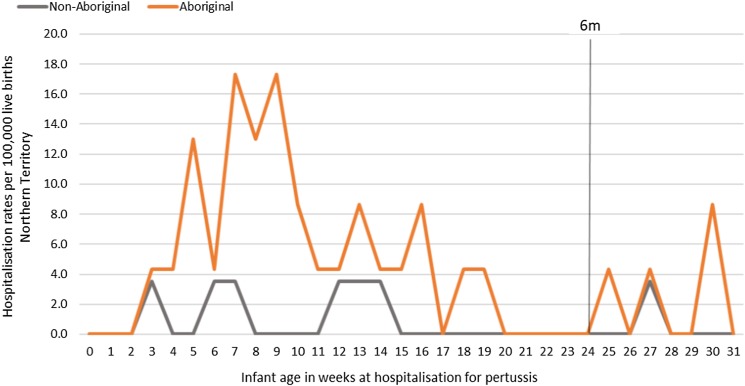
Pertussis hospitalisation rates per 100 000 live births in 0–<7 month old infants, by year of infant birth at time of hospitalisation, Northern Territory, Australia (2000–2014).